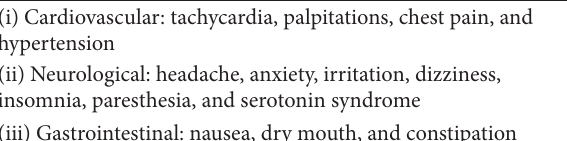
Table 2: Sibutramine overdose complications [2]. (i) Cardiovascular: tachycardia, palpitations, chest pain,